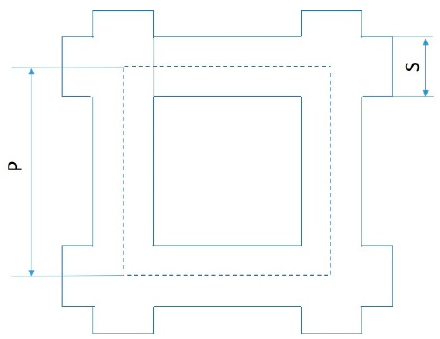
Figure 2. Schematic representation of the cubic (C) structure: P is the pore size, S is the strut diameter.